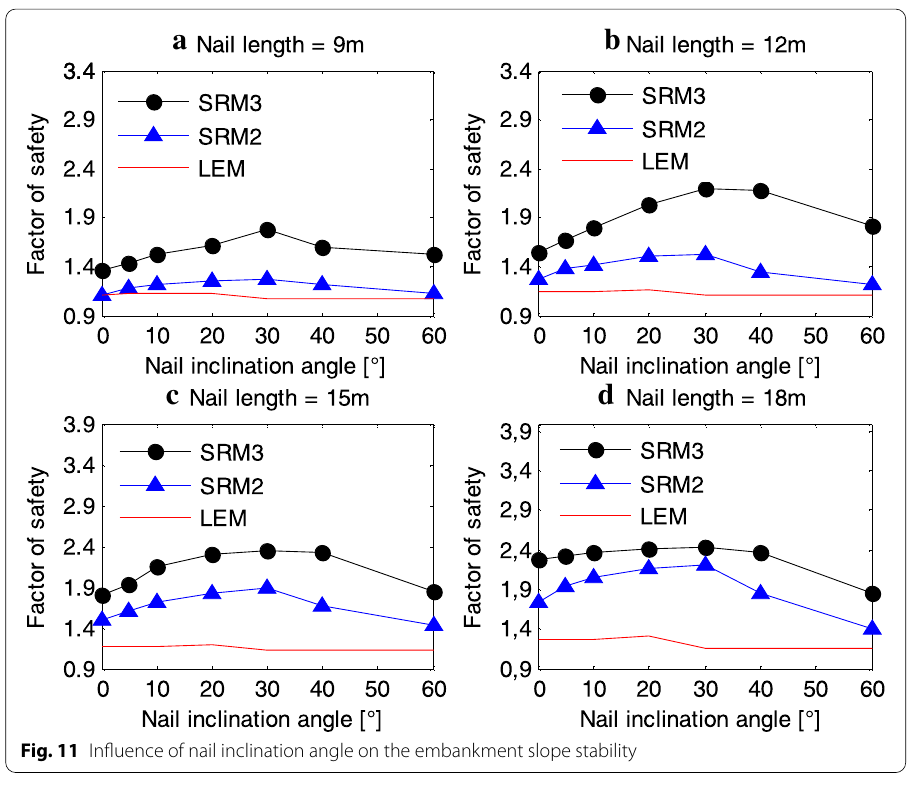
Fig. 11 Influence of nail inclination angle on the embankment slope stability